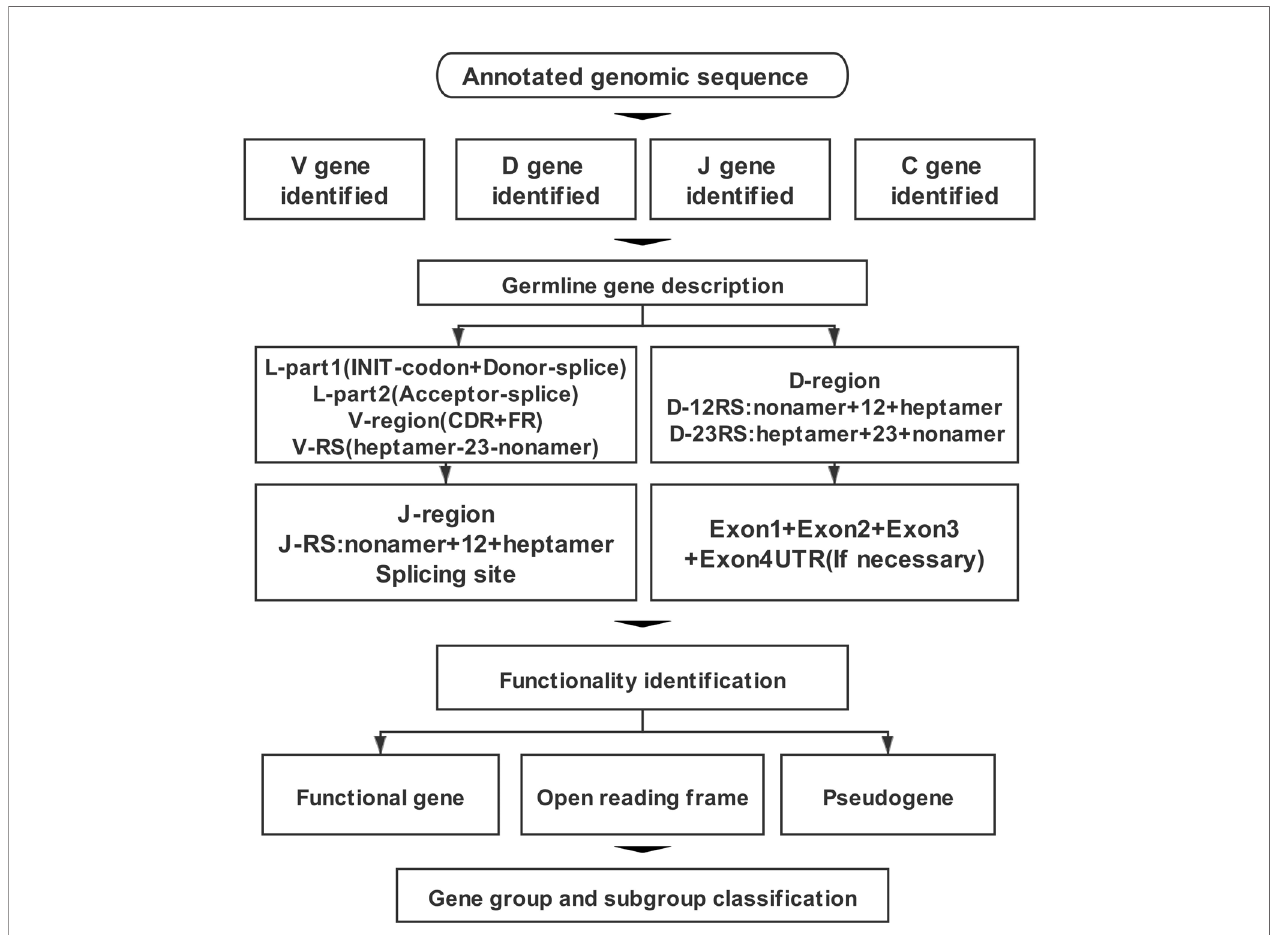
FIGURE 1 | The annotation process of T-cell antigen receptor (TR) locus includes four parts: identi fi cation, description, functional determination, and family clustering of germline